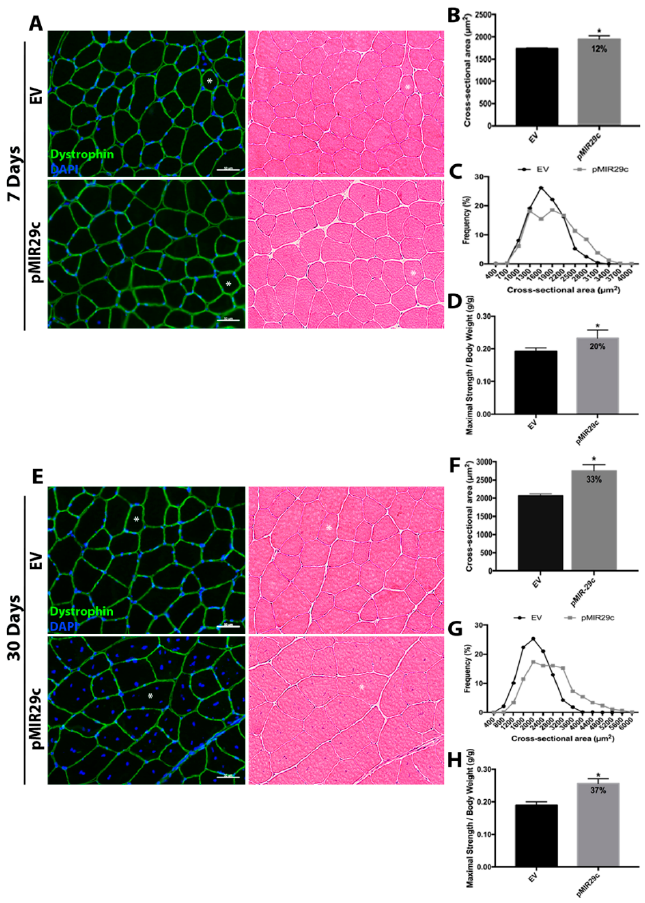
Figure 2. Histological and functional analysis after miR-29c overexpression for 7 and 30 days. ( A ) Representative immunofluorescence photomicrographic (Dystrophin in green and DAPI in blue) and hematoxylin/eosin staining (HE) of tibialis anterior muscle after 7 days and ( E ) 30 days of miR-29c overexpression (scale bar 50 µm, asterisk indicates the same muscle fiber). ( B ) Cross-sectional area of tibialis anterior muscle fibers after 7 and ( F ) 30 days of miR-29c overexpression ( n = 4–5). ( C ) Frequency distribution of the tibialis anterior muscle fibers by levels of fiber cross-sectional area after 7 and ( G ) 30 days of miR-29c overexpression. ( D ) Maximal strength after 7 and ( H ) 30 days of miR-29c overexpression ( n = 5). Data were expressed as mean and SEM. Statistical analysis included an unpaired t -test. * p < 0.05 vs. EV group.